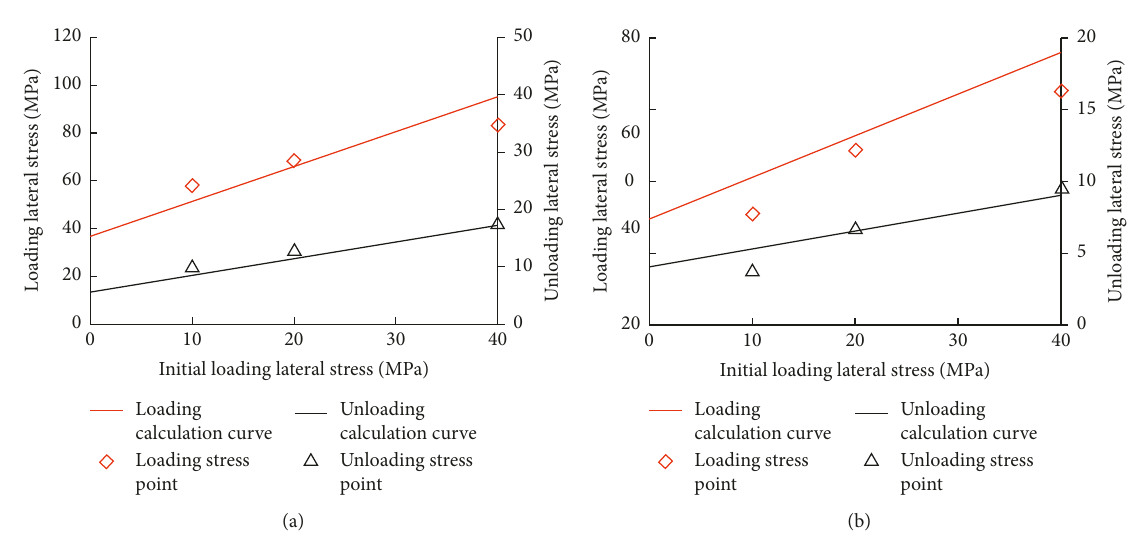
Figure 7: Stress-initial loading lateral stress plots. (a) Peak stress; (b) Yield